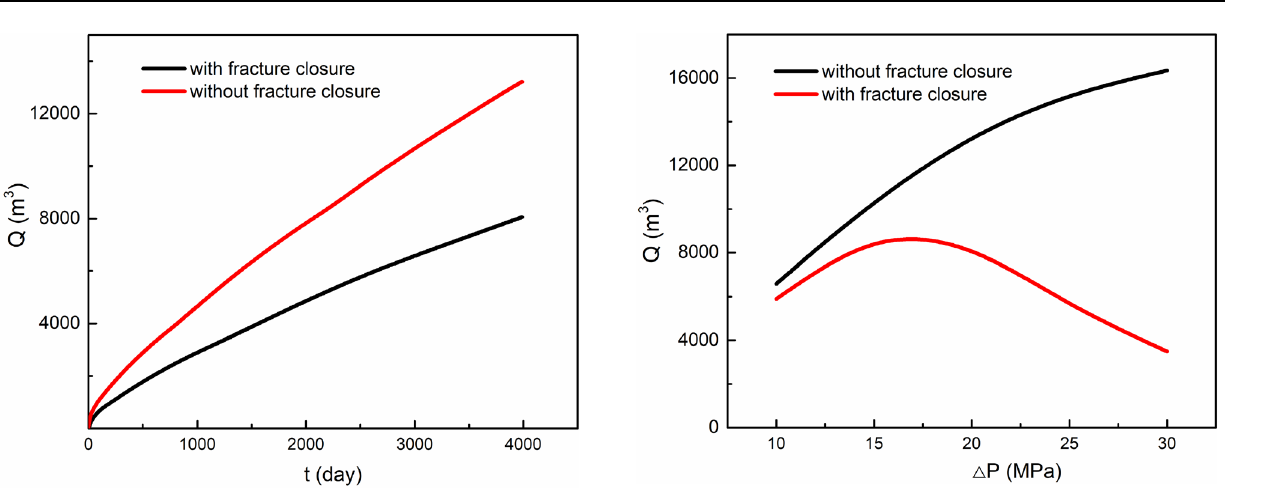
Fig. 9 Cumulative oil production curve Fig. 10 Cumulative oil production versus pressure drop for fracture